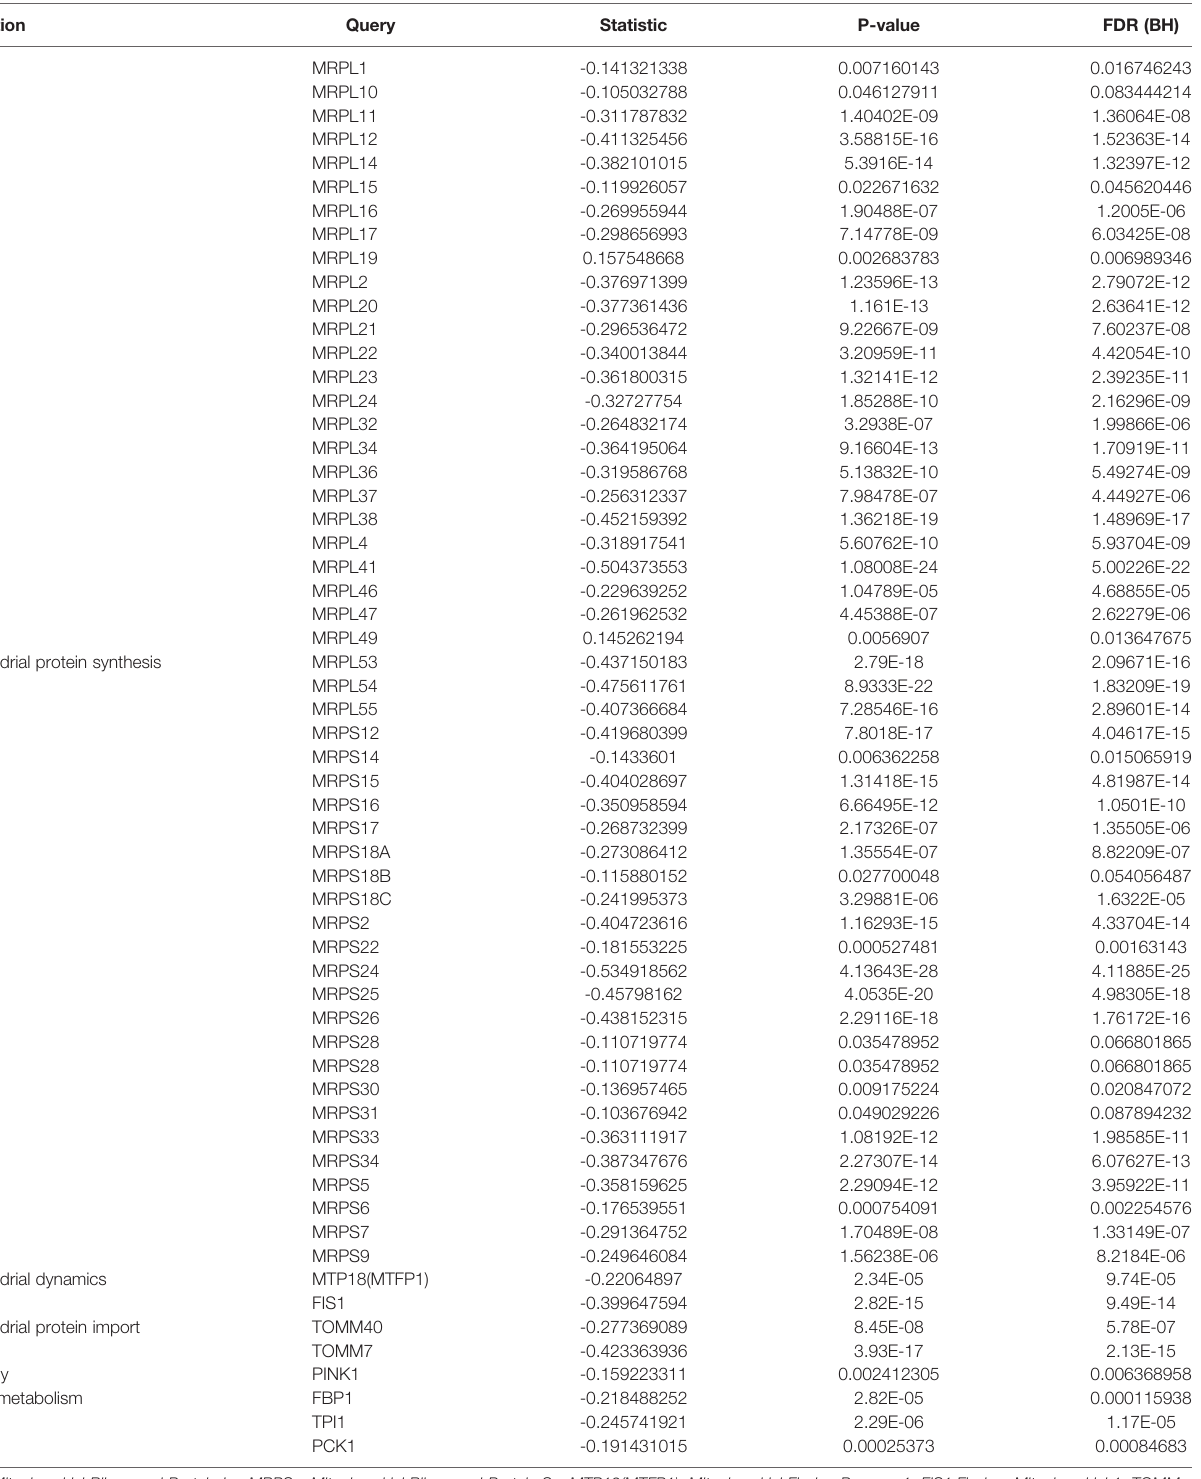
TABLE 1 | Relative expression of mitochondrial and glycolysis-associated genes in patients with high GMFB